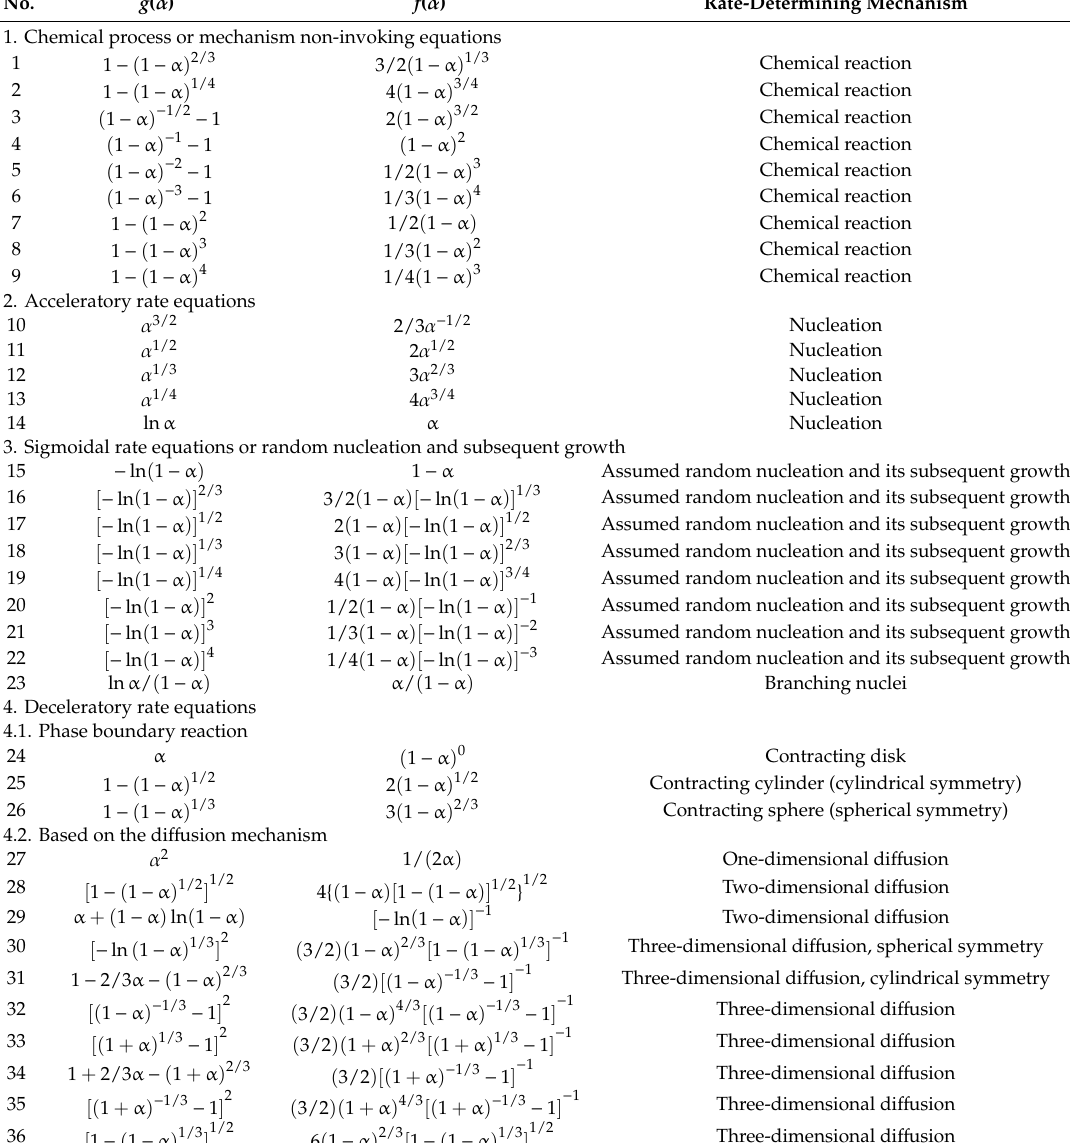
Table 2. The reaction model and mechanism used to describe solid-state pyrolysis